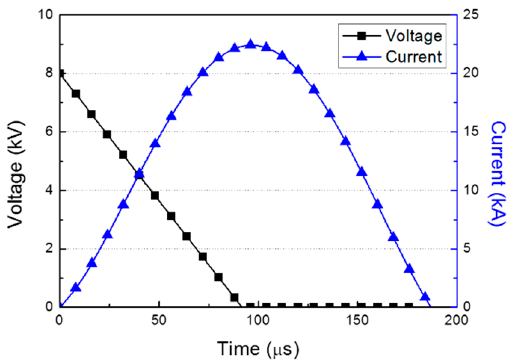
Figure 3. Voltage and current curves in the electrohydraulic forming experiment at 8 kV.